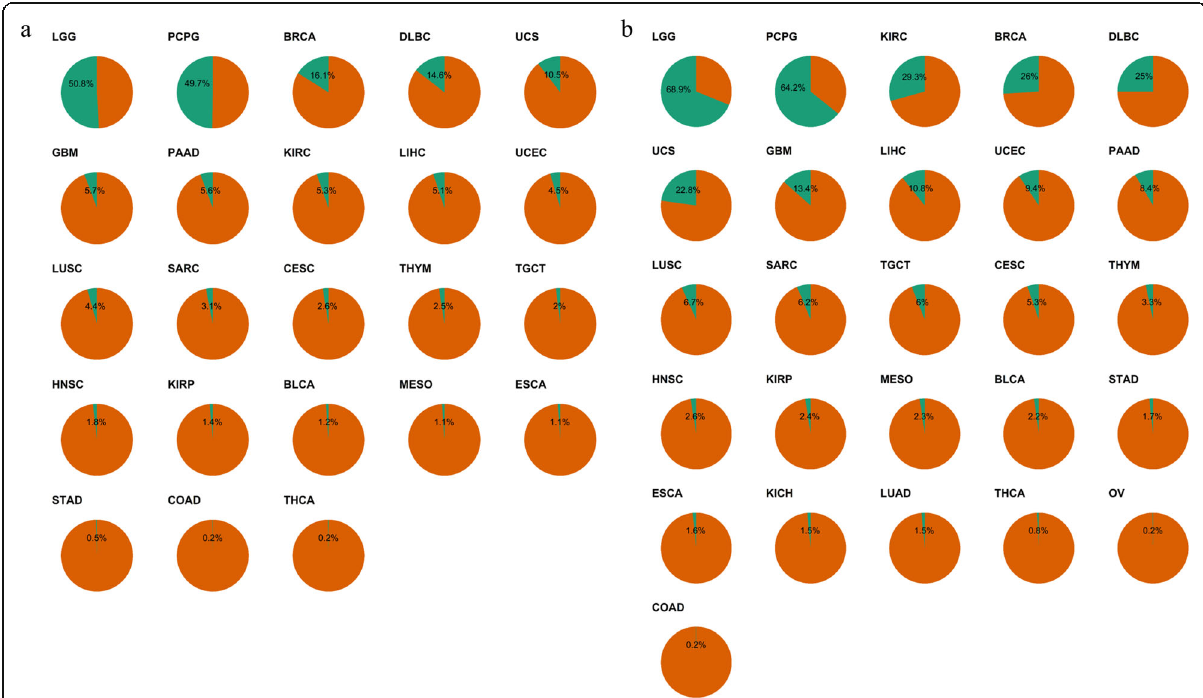
Fig. 2 Proportion of high-SST2 tumor in the pan-cancer. Green color represents a proportion of high-SST2 tumors of each tumor subtype based on the expression level of PCPG as a reference value ( a ) and the expression level of normal kidney tissue as a reference value ( b